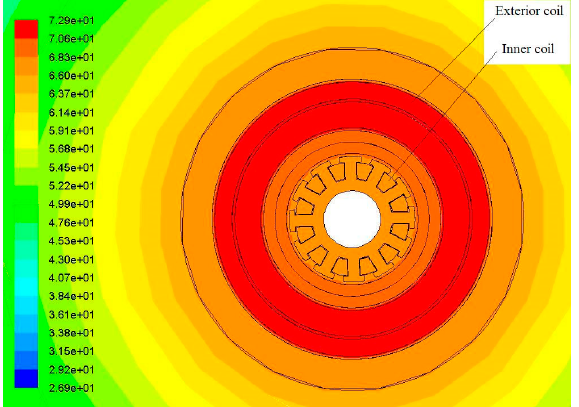
Figure 22. Ambient temperature of the RotLin motor.